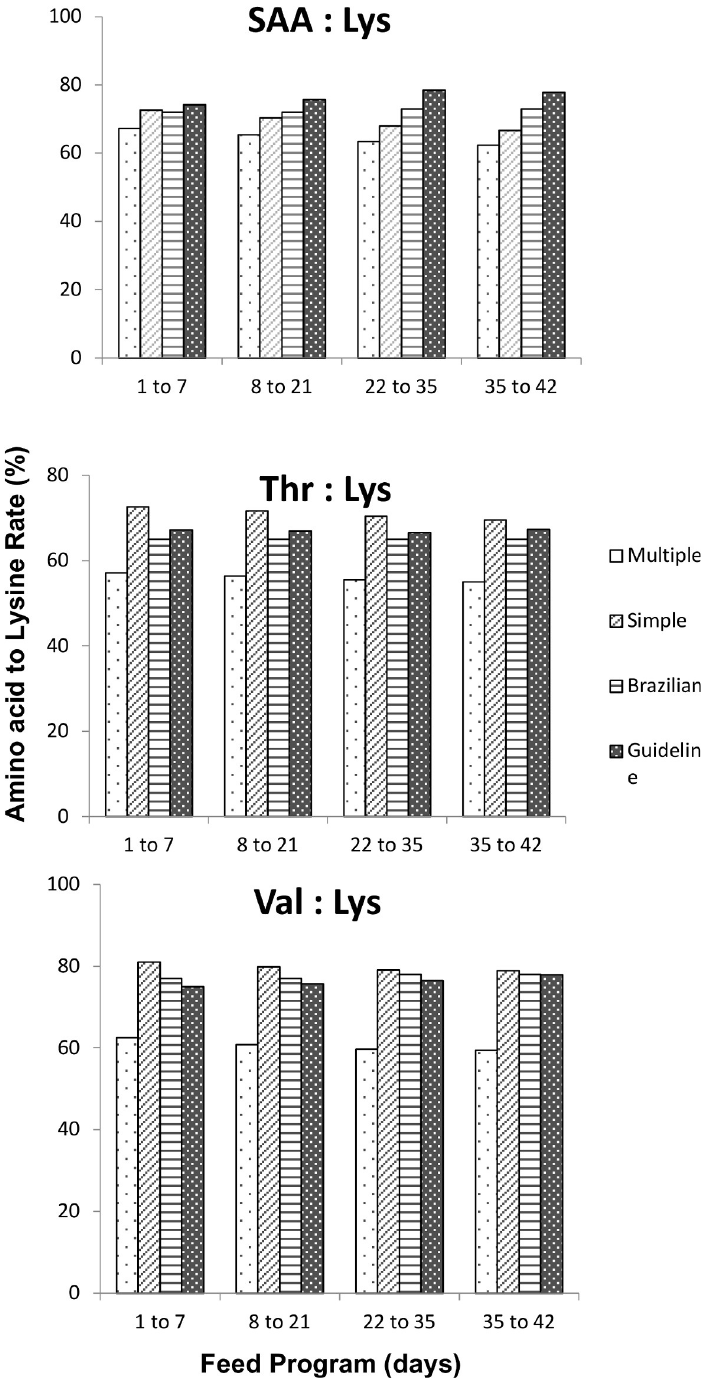
Fig 2. The ratio of sulfur-amino acid (SAA/Lys), threonine (Thr/Lys) and valine (Val/Lys) with lysine. The legend refers to adjusted and original factorial models, Brazilian Tables for Poultry and Swine (Brazilian) [31], and manual guide (Guideline)